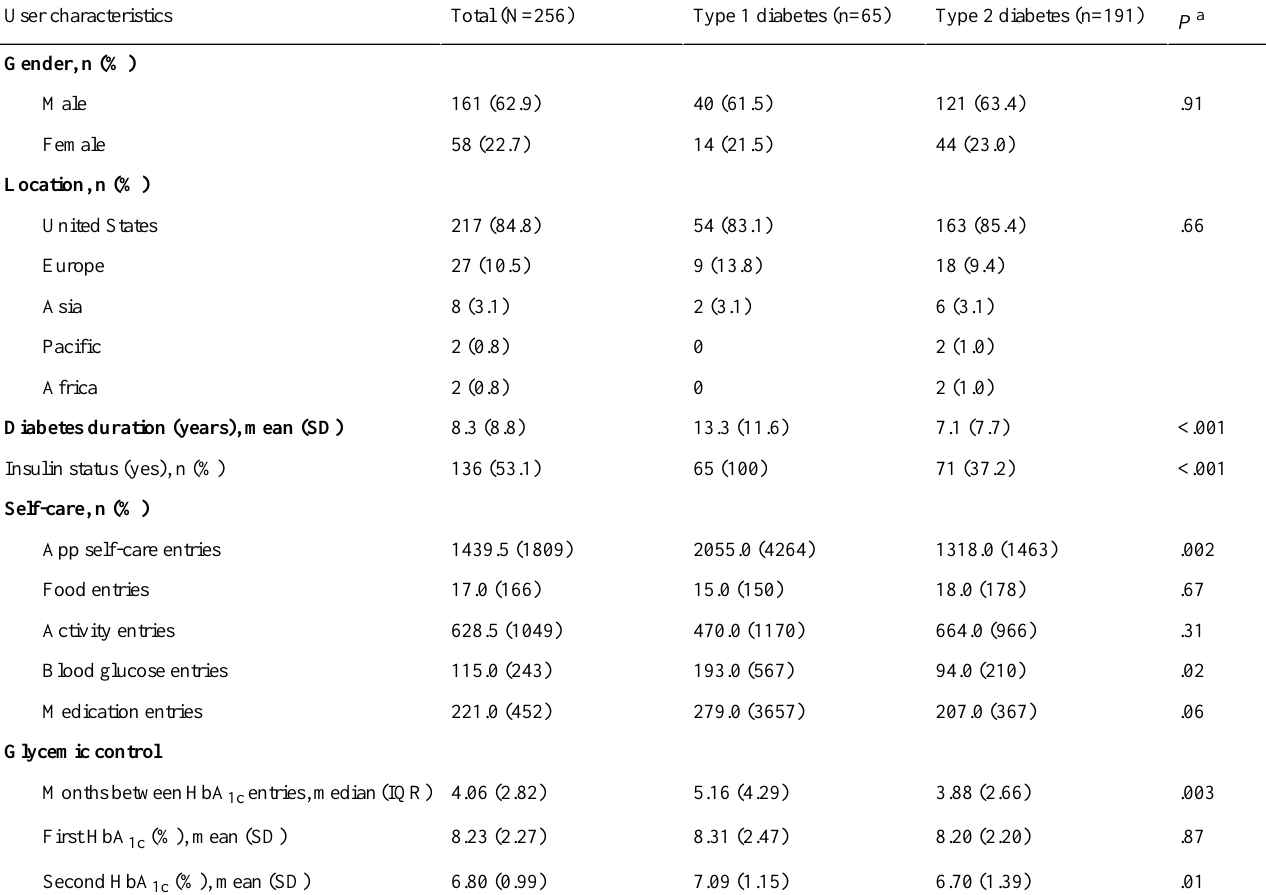
Table 1. Sample characteristics with tests of difference by diabetes